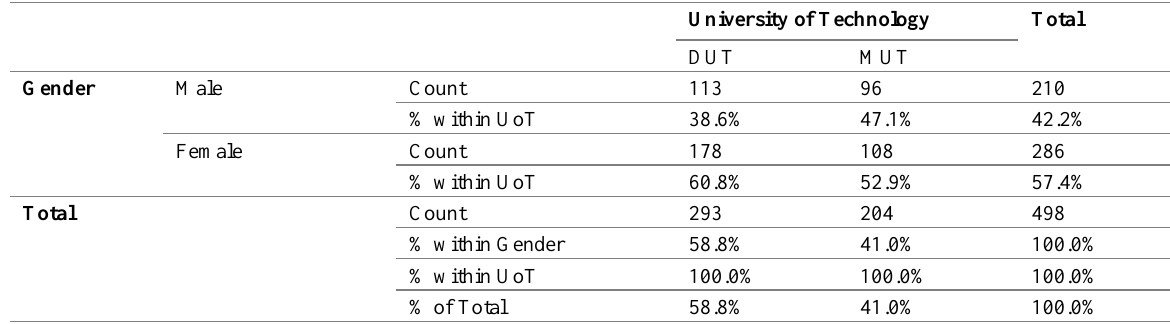
Table 2: Gender distribution by UoT